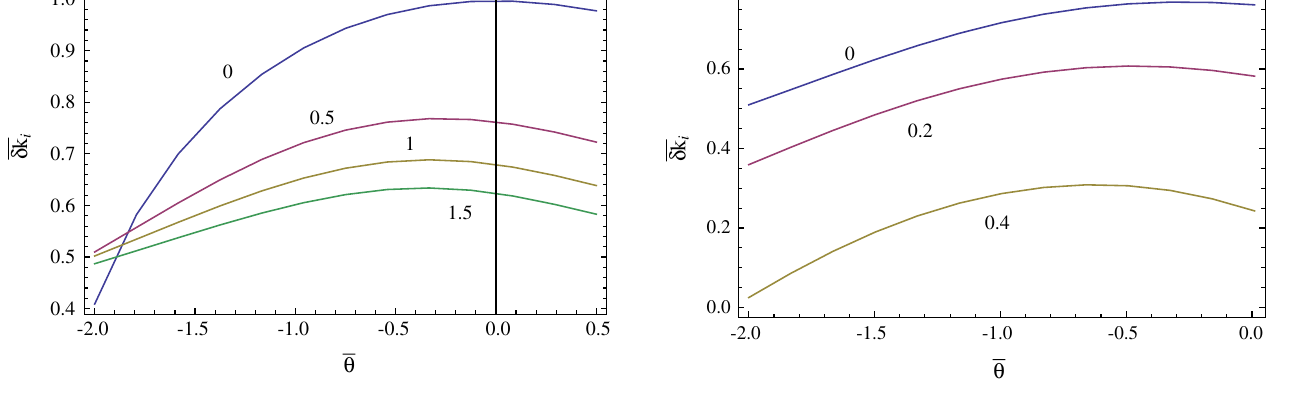
FIG. 4. Contribution of energy spread on 3D system: (cid:5)